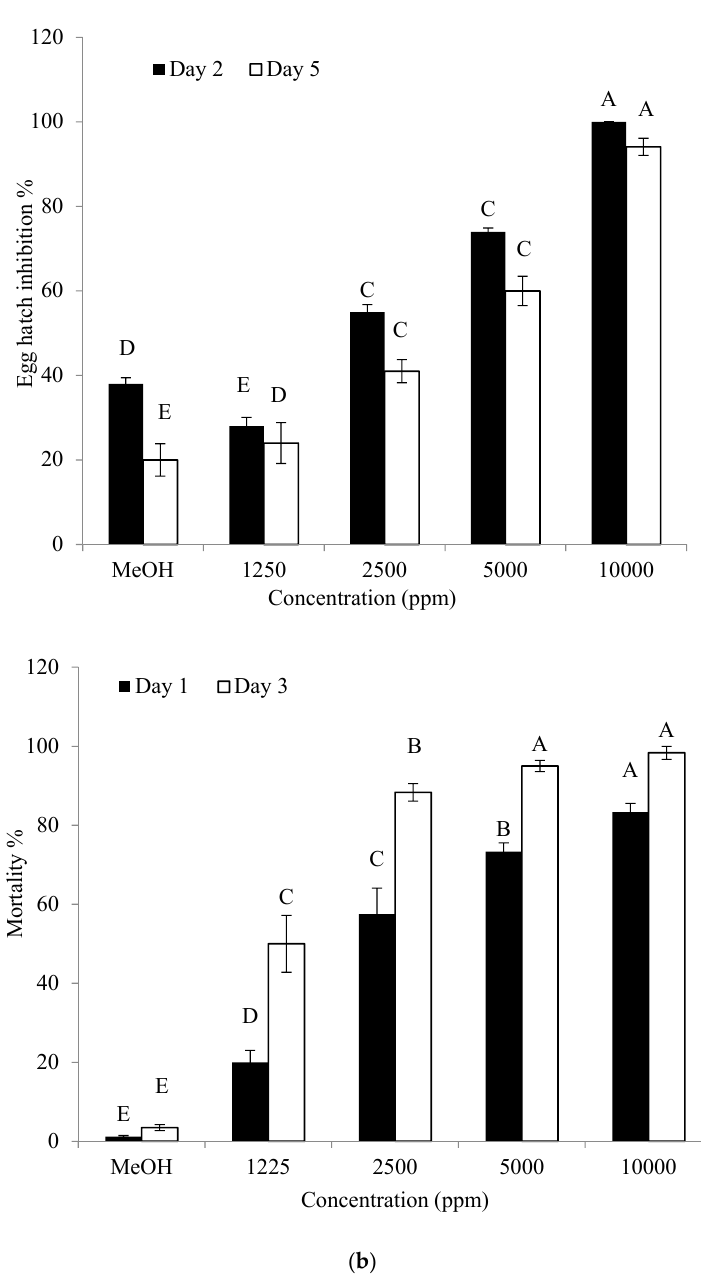
Figure 6. Effect of cyclo( D -Pro- L -Leu) purified from B. amyloliquefaciens Y1 culture on egg hatch ( a ) and second-stage juvenile (J2) mortality ( b ) of M. incognita at 26 °C for 2 and 5 days (eggs) and 1 and 3 days (J2) incubation. Methanol (MeOH) was used as control. Error bars represent standard error of the mean from three replicates. Means with the same letter in same observation time are not significantly different at p ≤ 0 . 05 when compared with LSD.